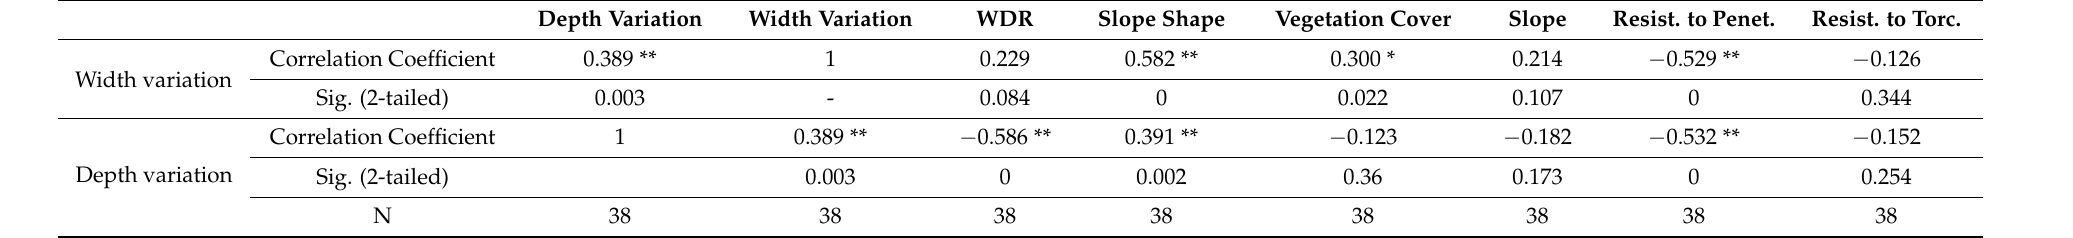
Table 2. Spearman correlation between depth variation and some independent variables.